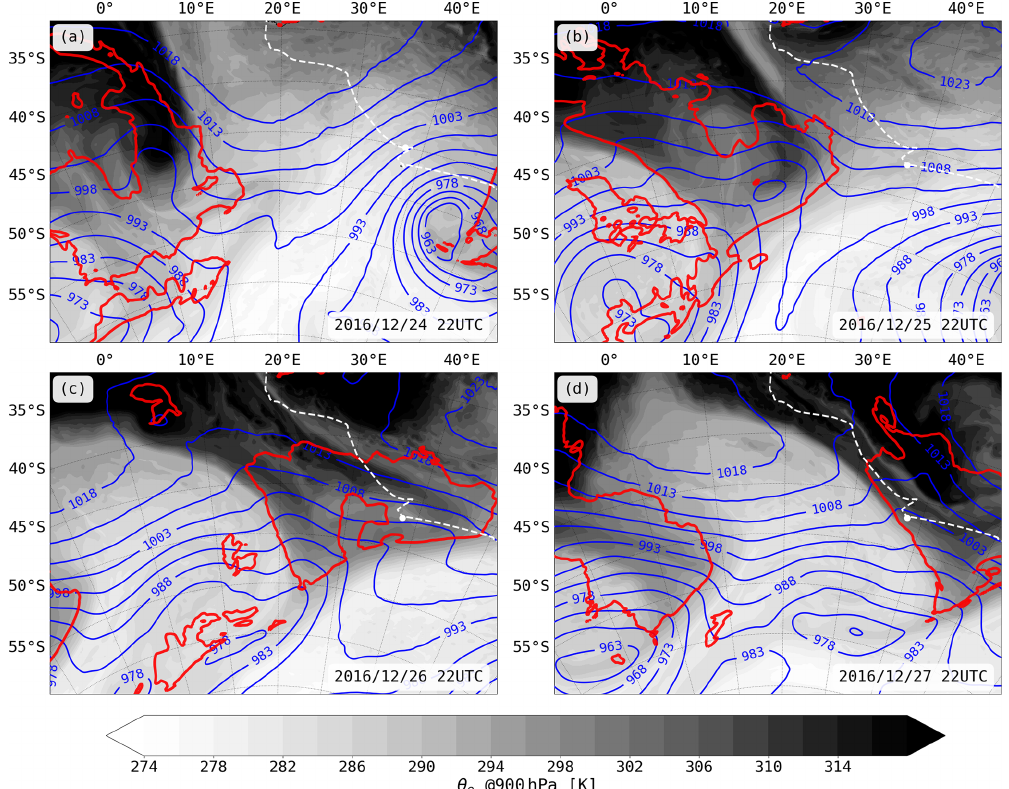
Figure 5. Horizontal cross sections of equivalent potential temperature at 900hPa ( θ e @900hPa) and sea level pressure (blue contours, inhPa) at four time steps during the warm advection case study. The white dashed line shows the ACE ship track, and the white dot denotes the position of the research vessel. The red contours show that warm temperature advection mask (see Sect. 4.1 for